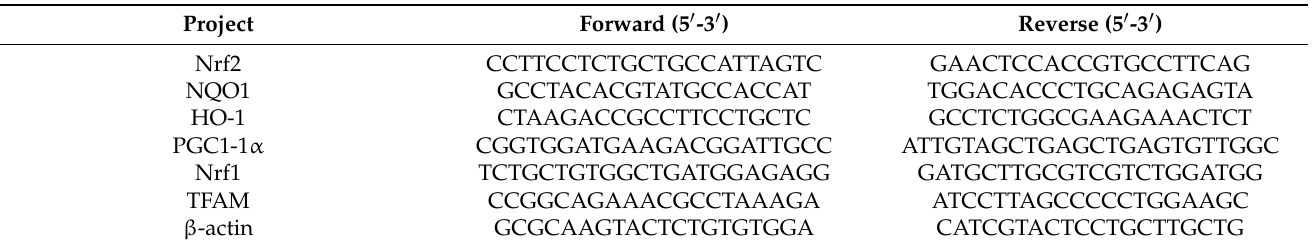
Table 1. RT-PCR primer